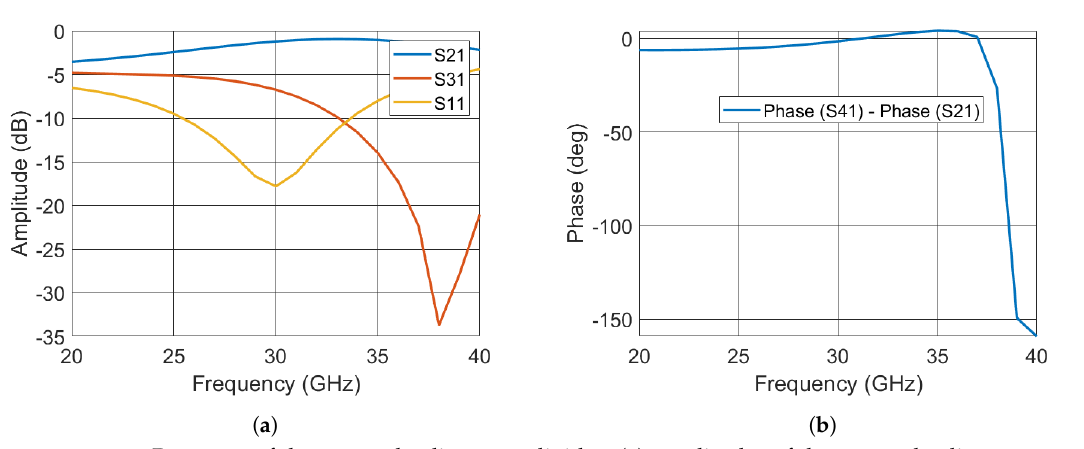
Figure 29. Response of the unequal split power divider: ( a ) amplitudes of the unequal split power divider output ports; and ( b ) phase difference between the unequal split power divider output ports.